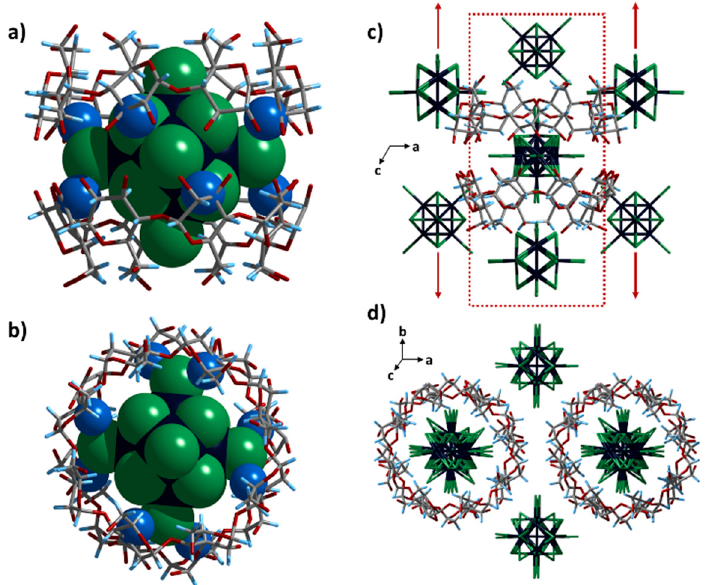
Figure 1. Selected fragments of crystal structure of Mo 6 Cl 14 @2CD·2Mo 6 Cl 14 . Side ( a ) and top ( b ) view of inclusion compound {[Mo 6 Cl i8 Cl a6 ]@( γ -CD) 2 } 2– . Highlight showing the close environment of the CD-free clusters: side ( c ) and top ( d ) view. Color code: Mo—dark blue, Cl—green, O—red, C—gray, H—light blue, H involved in hydrogen bonding—space-filling blue, Mo 6 -CD@Mo 6 @CD-Mo 6 complex—red frame. Red arrows indicate growing directions of omitted Mo 6 -CD@Mo 6 @CD-Mo 6 complex. Disordering of cluster is omitted for clarity in pictures ( a , b ).